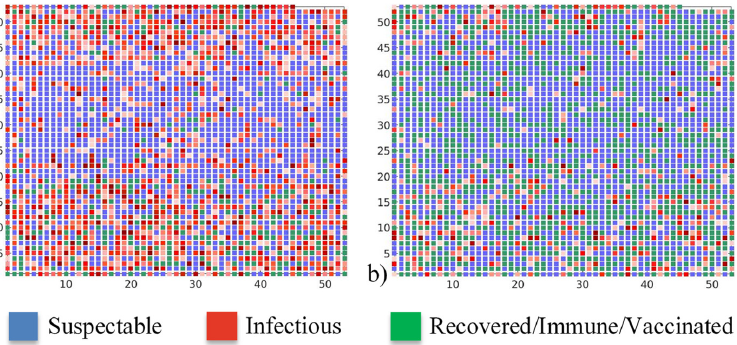
Figure 13. Daily numbers of susceptible, infectious, and recovered/immune/vaccinated at the peak of the epidemic. Case: ( a ) no vaccination, ( b ) general population contact-based vaccination with 30% of pre-existing immunity. Axis numbers represent graph nodes (modelled individuals), each square corresponds to a single graph node.